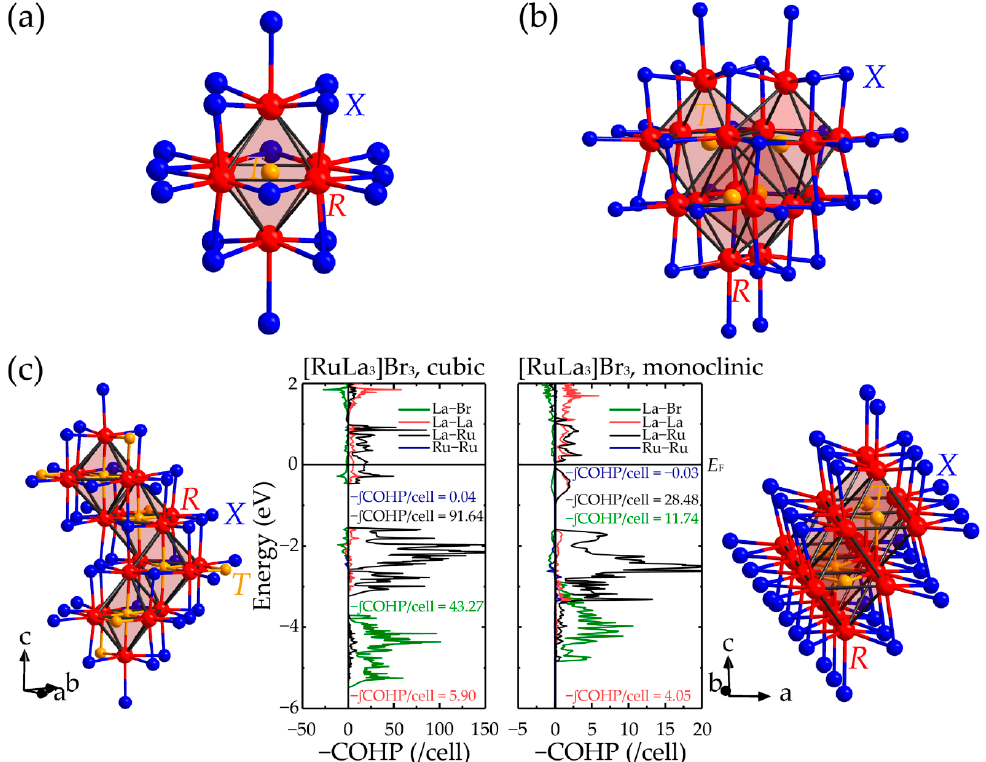
Figure 1. Representations of: ( a ) isolated; ( b ) tetrameric; and ( c ) chains of transition-metal (yellow) centered rare-earth-metal clusters (red) enclosed by halide ligands (blue). For instance, isolated rare-earth-metal clusters ( a ) enclosing endohedral transition-metal atoms are observed for the halides crystallizing with the [ TR 6 ] X 12 R -type and [ TR 6 ] X 10 -type, respectively, while tetrameric clusters shown in ( b ) have been identified for four different types of rare-earth transition-metal halides, i.e., the [ T 4 R 16 ] X 28 [ R 4 ], [ T 4 R 16 ] X 20 , [ T 4 R 16 ] X 24 [ RX 3 ] 4 , and [ T 4 R 16 ] X 24 types of structure. In the case of the [ TR 3 ] X 3 -type compounds shown in ( c ) two structurally independent types of structure have been identified (left: cubic; and right: monoclinic; see main text for further information). The − COHP curves and the integrated values corresponding to the diverse homoatomic and heteroatomic interactions have been included for two prototypical examples of the [ TR 3 ] X 3 -type. The Fermi level, E F , is represented by the black horizontal lines in the representations of the − COHP curves.